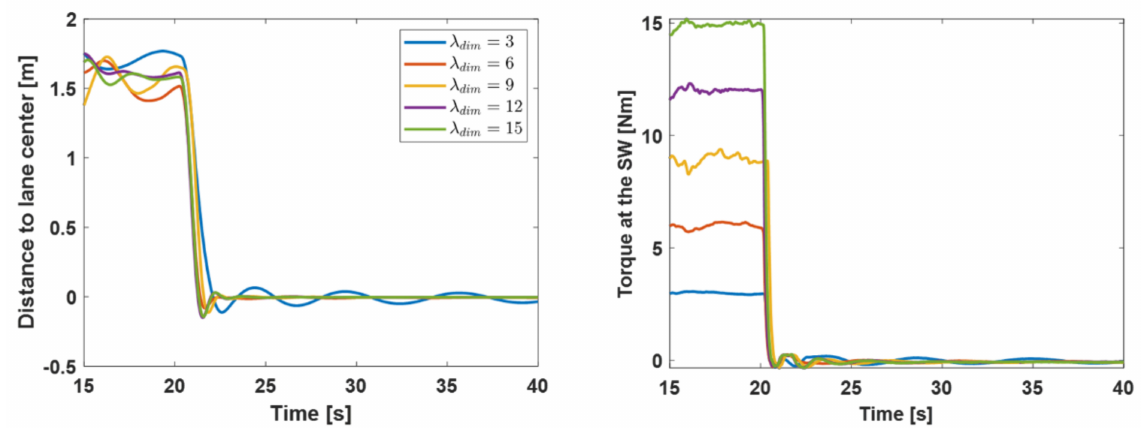
Figure 4. Stability test with variable damping ( b λ